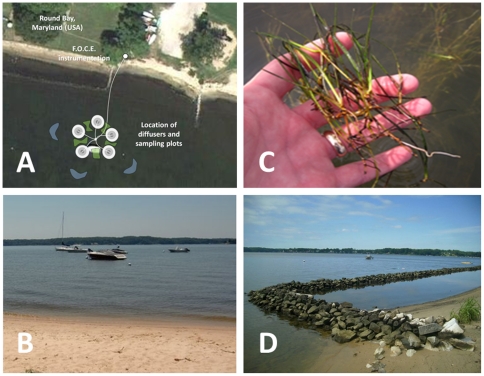
Location of low-salinity Free Ocean Carbon Enrichment (FOCE) experiments in the Severn River, Maryland (USA) in June-July 2011.(A) Individual CO2 diffusers (white) generated halos of high CO2/low pH conditions (5 cm and 40 cm distances in grey; 100 cm locations in green; 500 cm ambient sites in blue.) The FOCE system instrument package was located on shore (B,D) and maintained high CO2/low pH conditions within mixed-species meadows of widgeon grass (Ruppia maritima) and redhead grass (Potamogeton perfoliatus) (C).